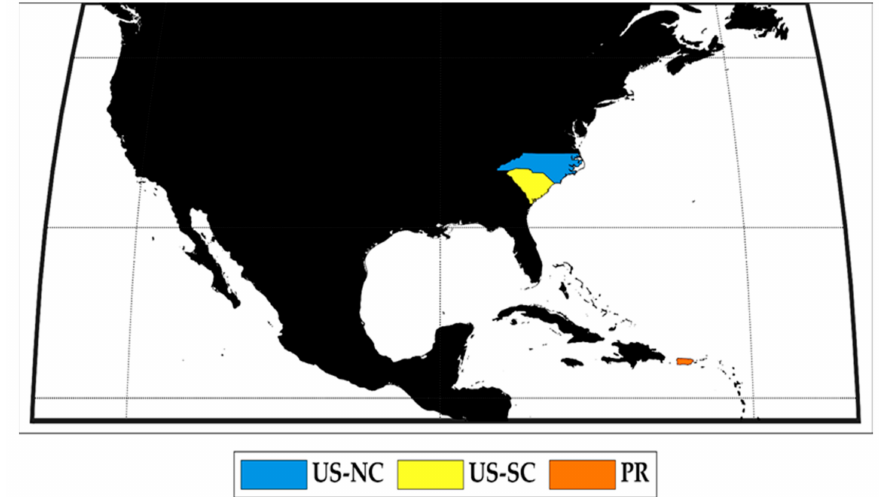
Figure 1. This Map shows some of the locations where the Airborne Optical Systems Testbed (AOST) collected Lidar data after major